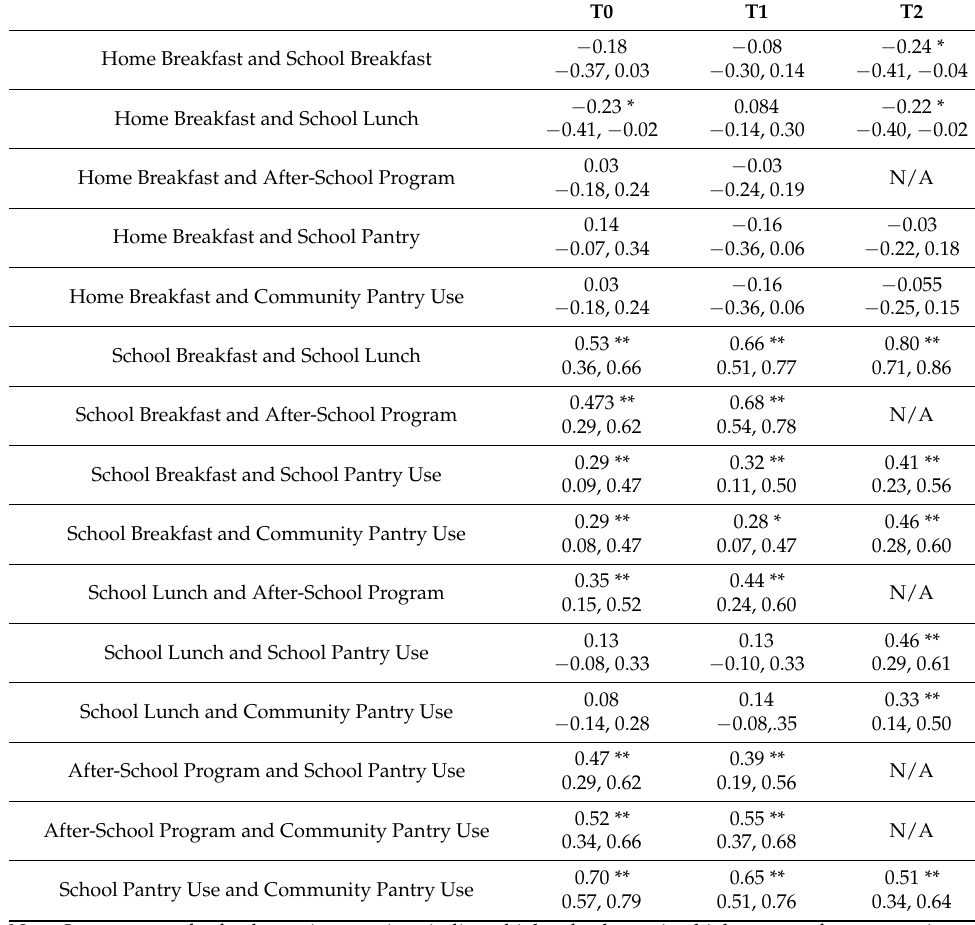
Table 4. Pearson correlations with 95% CI for program use and food security variables at each time